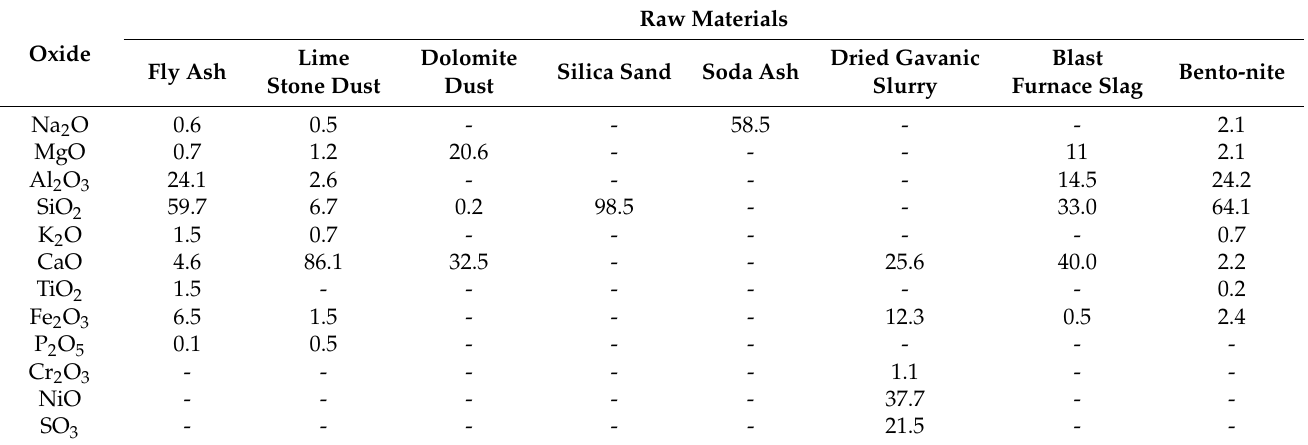
Table 1. Chemical composition (wt.%) of different industrial wastes and other raw materials used to formulate glass coating composition.